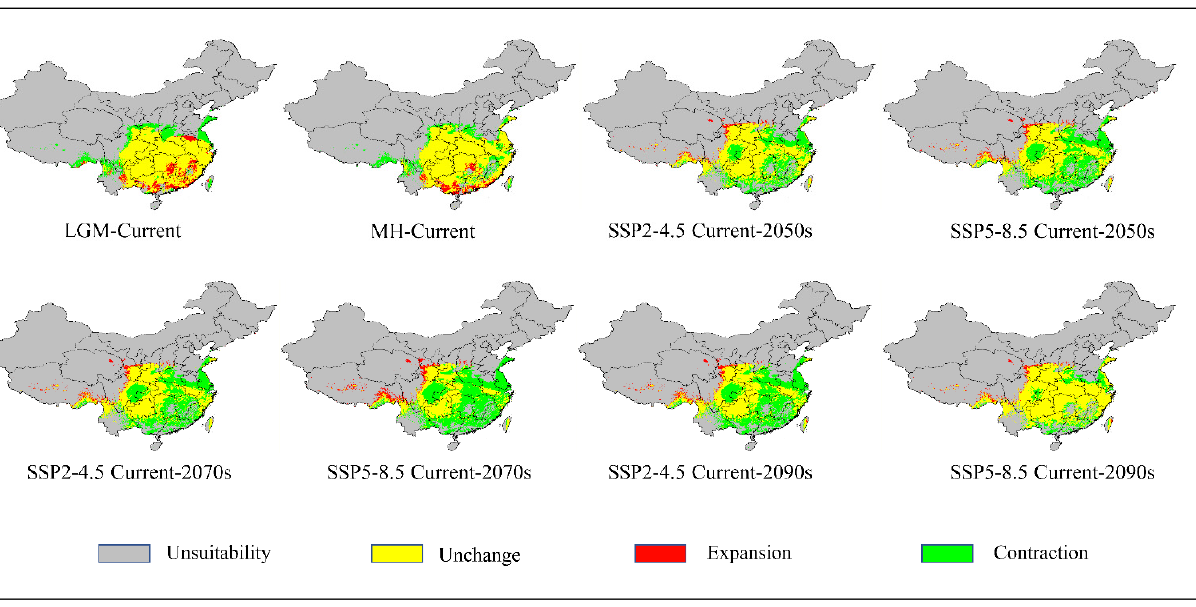
Figure 4. Changes in potential suitable areas of C. appendiculata under current and future climate conditions.